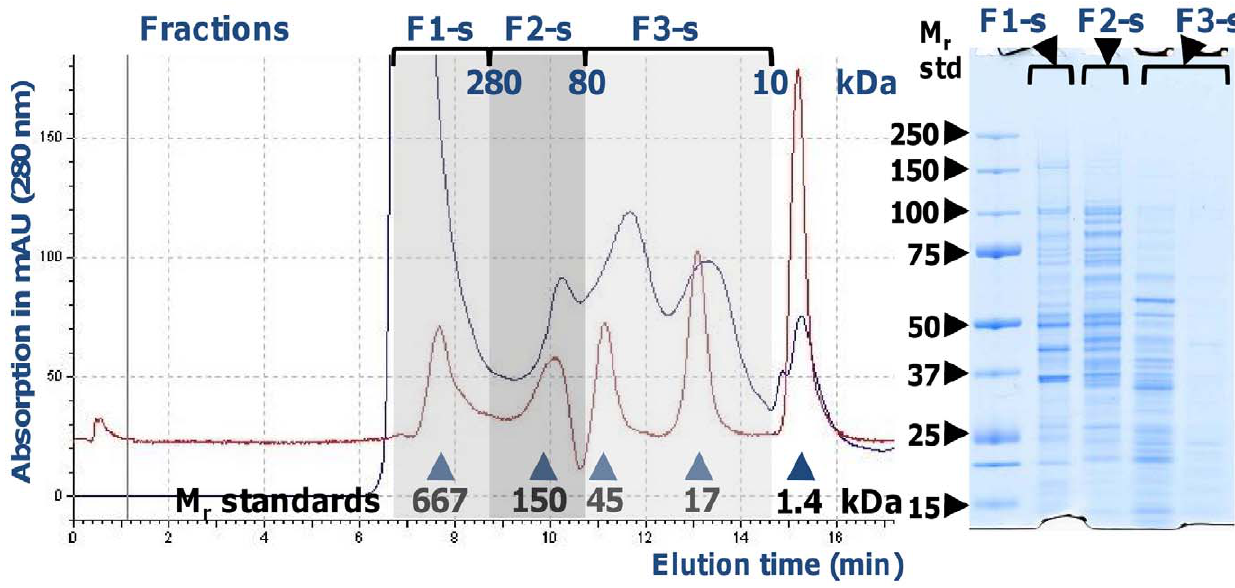
Figure 2. Size exclusion chromatography fractionating E.coli O157:H7 cell lysate proteins prior to 2D-LC-MS/MS. The fractions (F1-s, F2-s and F3-s) were eluted from the G3000-SWXL column in PBS and 0.01% Triton X-100 and pooled as shown in the chromatogram. The A 280 profiles are shown for an EHEC lysate sample and a mixture of five M r protein standards, the latter of which pertains to the line with a low void volume peak at 667 kDa. Protein separations occurred in the 500-10 kDa range. On the right, protein bands visualized by Coomassie Blue staining in a 4–12%T SDS-PAGE gel are shown in the same order as the SEC fractions (with F3-s before pooling in two consecutive SEC fractions).